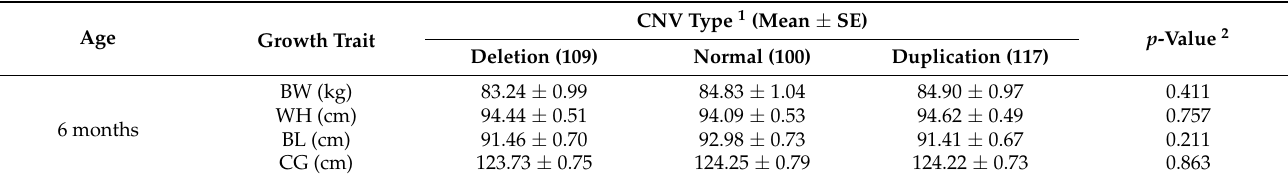
Table 3. Association analysis between SOX8-CNV and growth